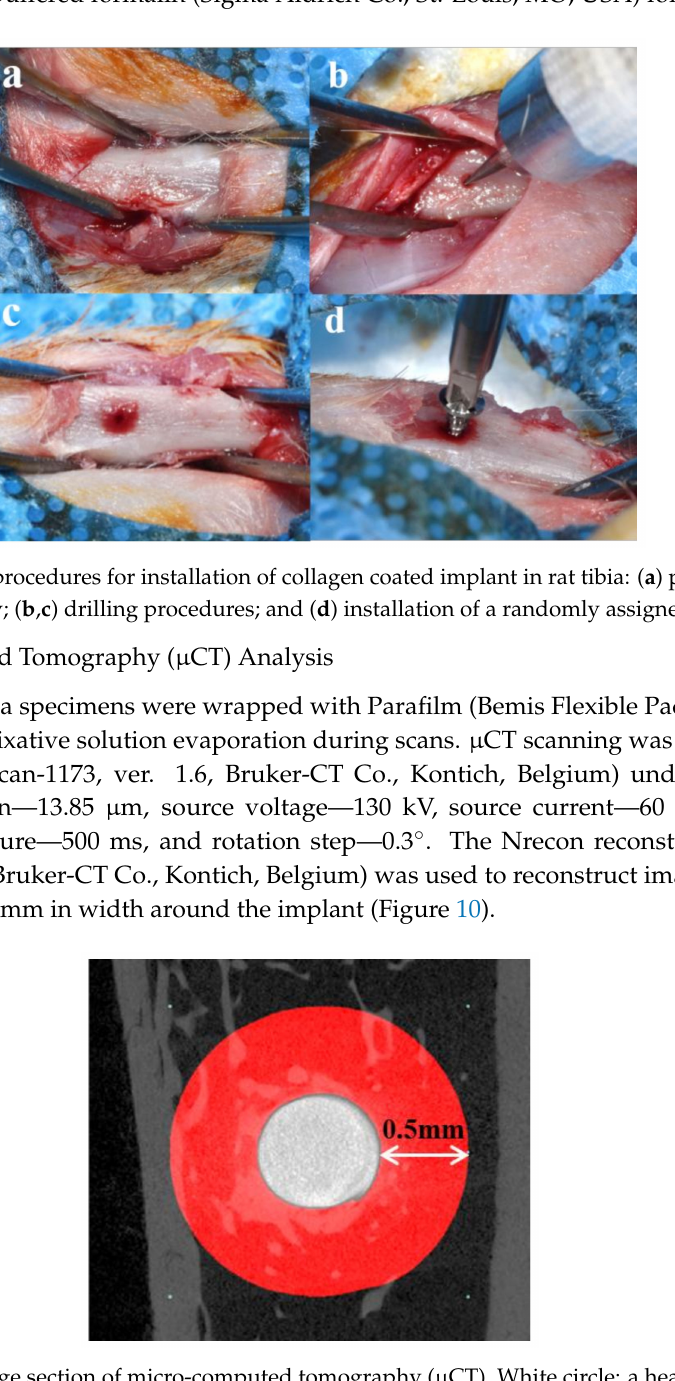
Figure 10. The image section of micro-computed tomography ( µ CT). White circle: a head of installed implant; Red region: region of interest (ROI) of bone volume